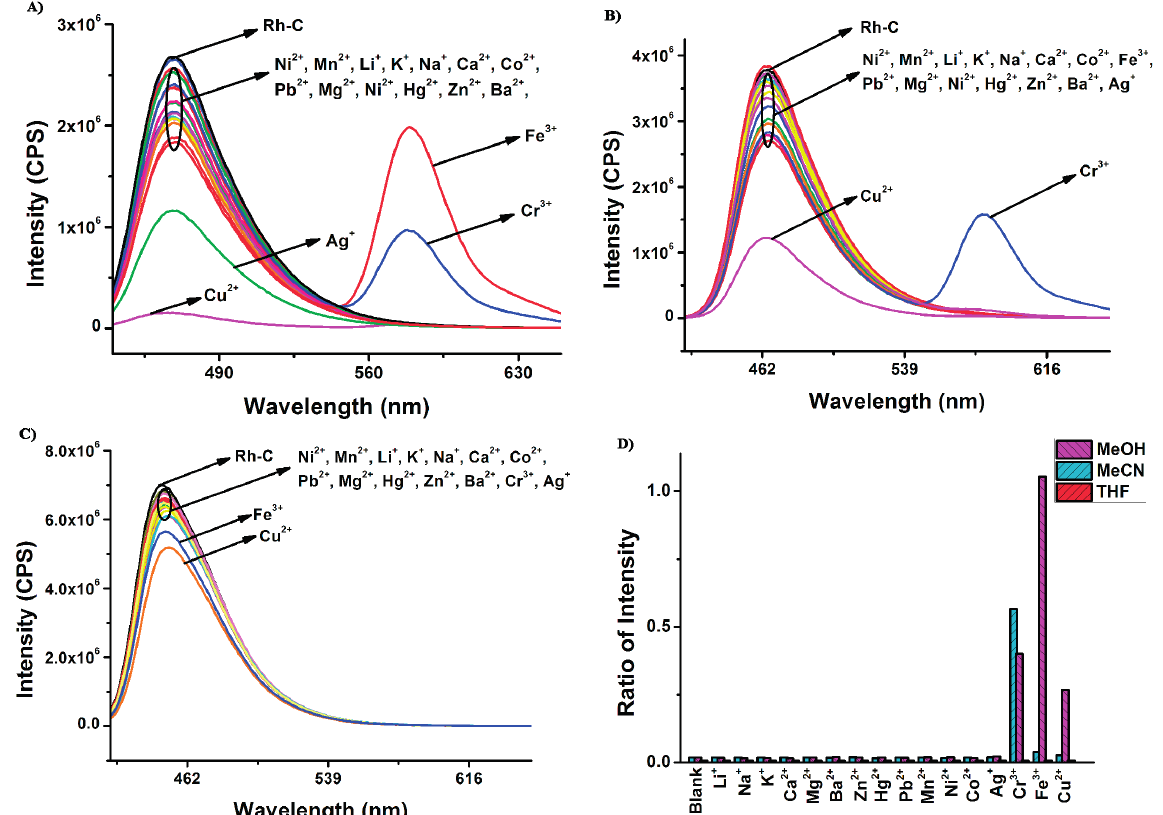
Figure 3. The fluorescence response of Rh-C (5 μ M) upon addition of different metal ions (100 μ M). ( A ) in MeOH ( λ ex = 420 nm); ( B ) in MeCN ( λ ex = 400 nm); ( C ) in THF ( λ ex = 400 nm); ( D ) The ratiometric absorption of Rh-C (5 μ M) upon addition of different metal ions (100 μ M. MeOH: I 579 /I 470 , MeCN: I 581 /I 463 , THF: I 580 / I 450